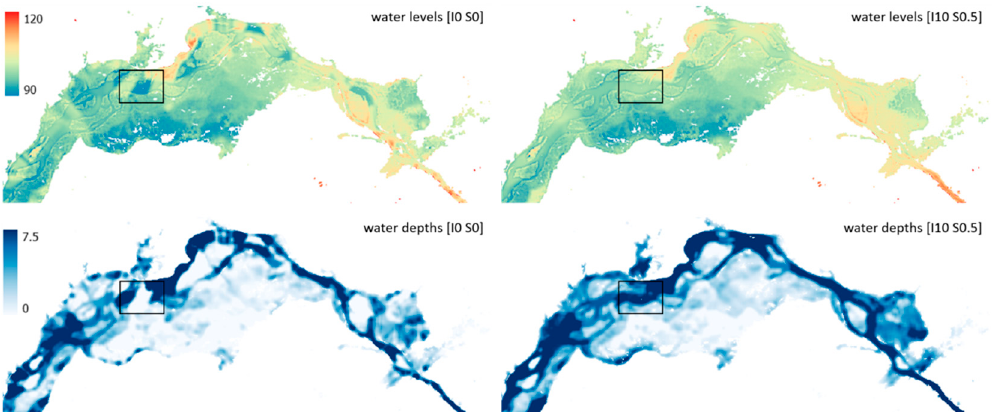
Figure 9. Results of FwDET2.1 using MERIT DEM and flood map derived from Sentinel-1 imagery of 16 July 2019. The location of an area with substantial changes between the two FwDET2.1 settings ([I0 S0] and [I10 S0.5]) is highlighted in each image and will be described in more detail further